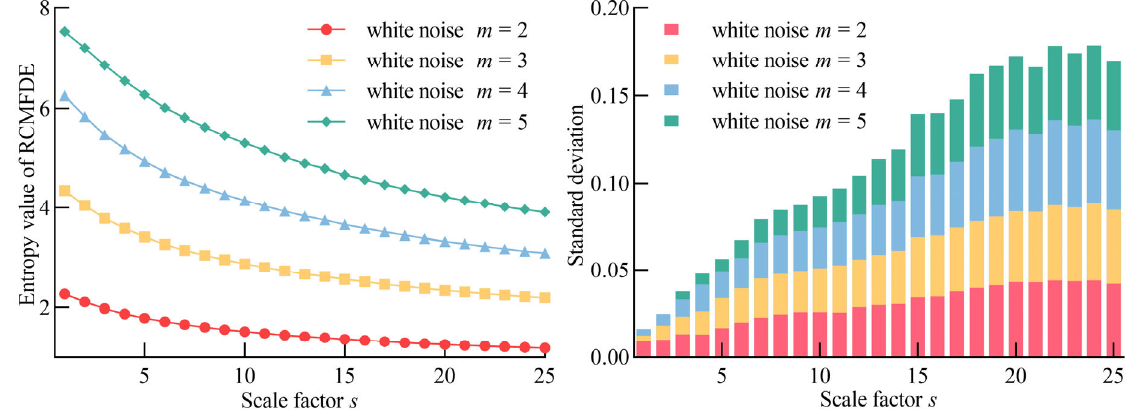
Figure 4. Effect of parameter m on RCMFDE.